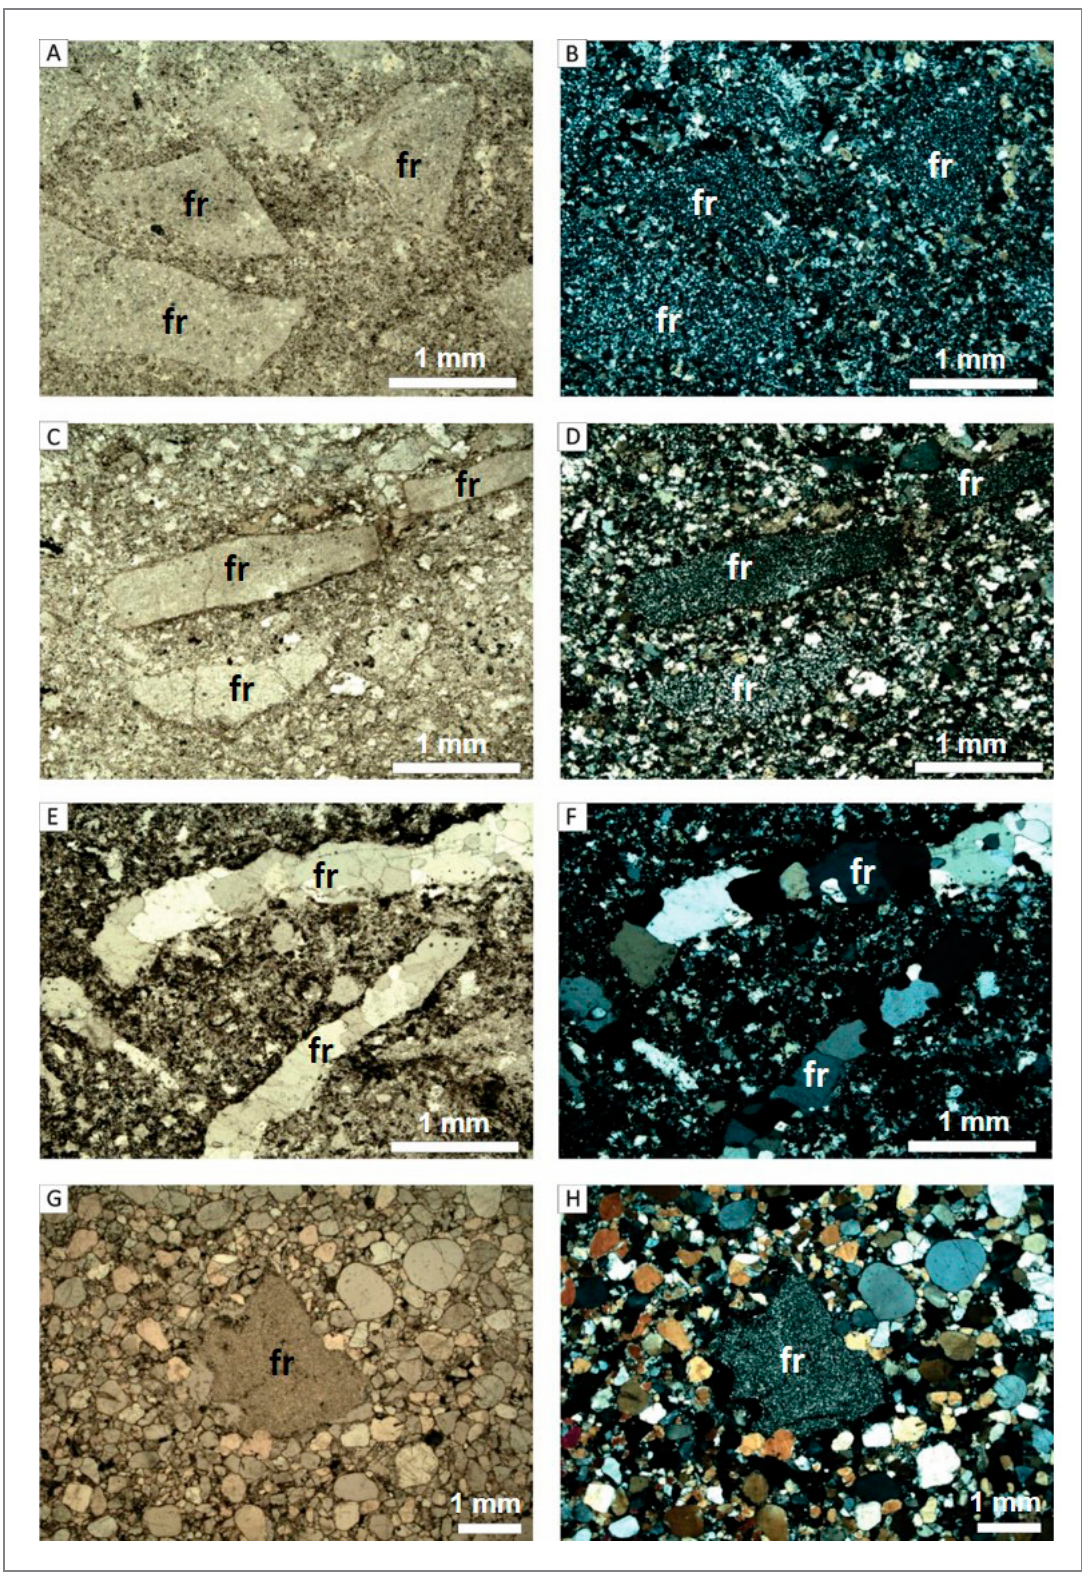
FIGURE 6 - Microscopic features of the breccias. (A) Angular metachert fragments (fr) set in siliceous microcrystalline cement. Plane-polarized light. (B) Same image taken under cross-polarized light to show that the metachert fragments (fr) are made up of microcrystalline quartz of a fairly small and uniform grain size; (C) Lath-shaped metachert fragments (fr) set in fine, possibly clastic-siliceous, embedding material. Plane- polarized light. (D) Same image taken under cross-polarized light. (E) Elongate fragments (fr) made up of subhedral quartz crystals enclosed in a fine, possibly clastic-chemical, material. Plane-polarized light. (F) Same image taken under cross-polarized light. (G) Subangular metachert fragment (fr) set in a metarenite matrix which in this case displays negligible evidence of metamorphism. Plane-polarized light. (H) Same image taken under cross-polarized